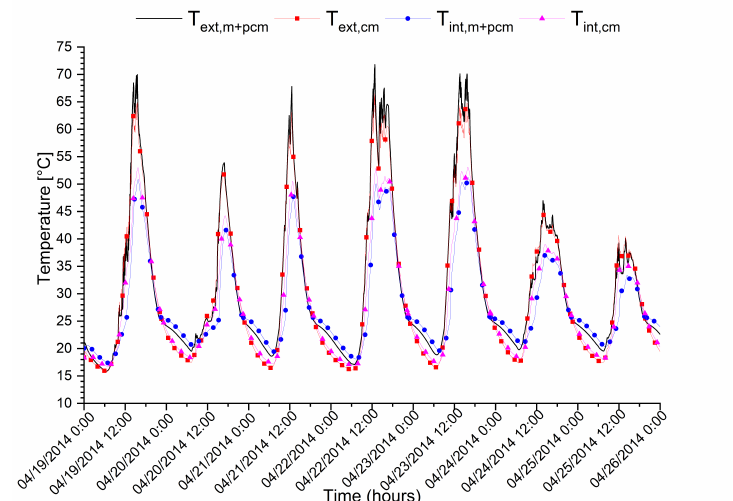
Figure 15. Comparison of temperature on both sides of the storage wall (cement mortar and mortar containing PCM). T ext,m+pcm and T ext,cm denote respectively the evolution in numerical temperatures on the exterior surface of the storage wall made from mortar containing PCM and that made from cement mortar; T int,m+pcm and T int,cm denote respectively the evolution in numerical temperatures on the interior surface of the storage wall made from mortar containing PCM and that made from cement mortar.